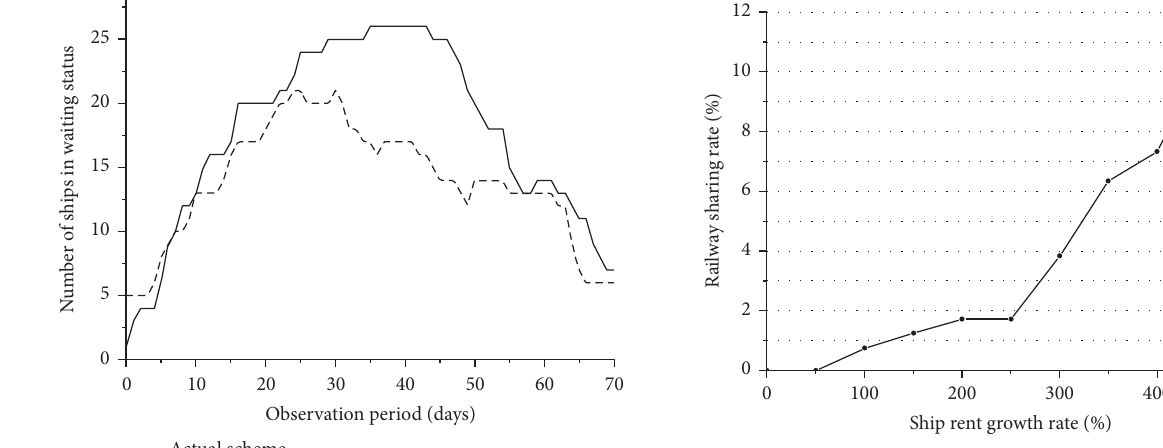
Figure 8: Relationship between ship rent growth and the railway freight sharing